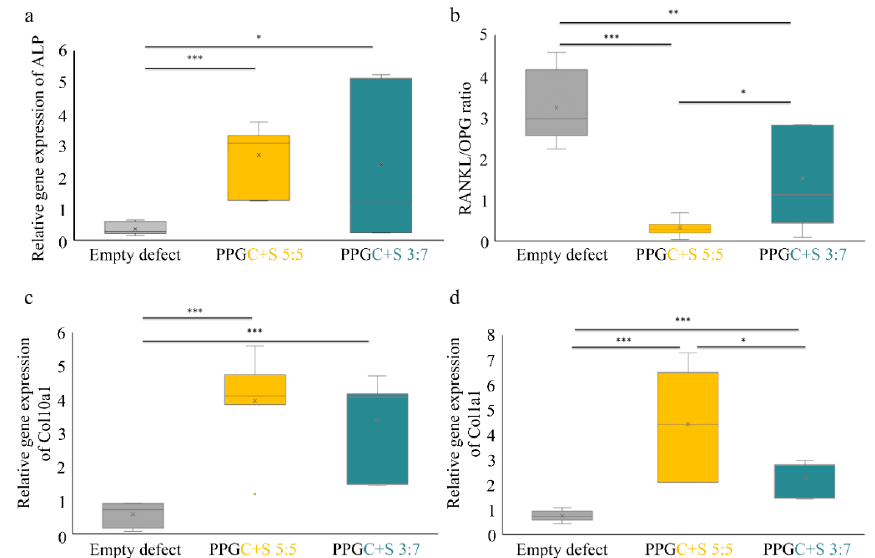
Figure 11. Gene expression analysis of ALP, RANKL/OPG, Col10a1, and Col1a1. Asterisks indicate statistical significant differences (* p < 0.05; ** p < 0.01; *** p < 0.001).